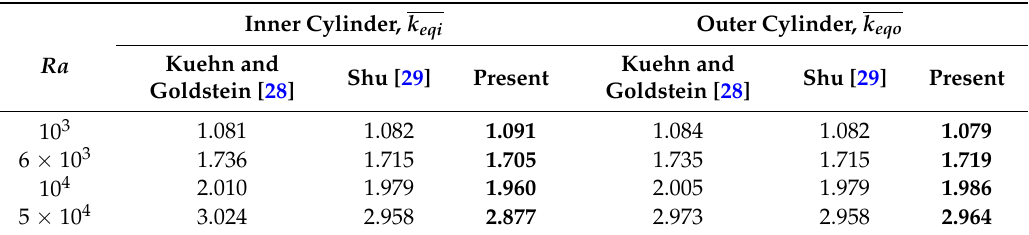
Table 6. Comparison of average equivalent heat conductivity at different Rayleigh numbers.